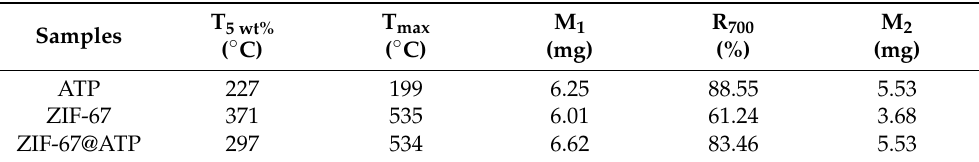
Figure 2. ( a ) TGA curves of ATP, ZIF-67 and ZIF-67@ATP; ( b ) DTG curves of ATP, ZIF-67 and ZIF-67@ATP. Table 2. TGA data for ATP, ZIF-67 and ZIF-67@ATP.